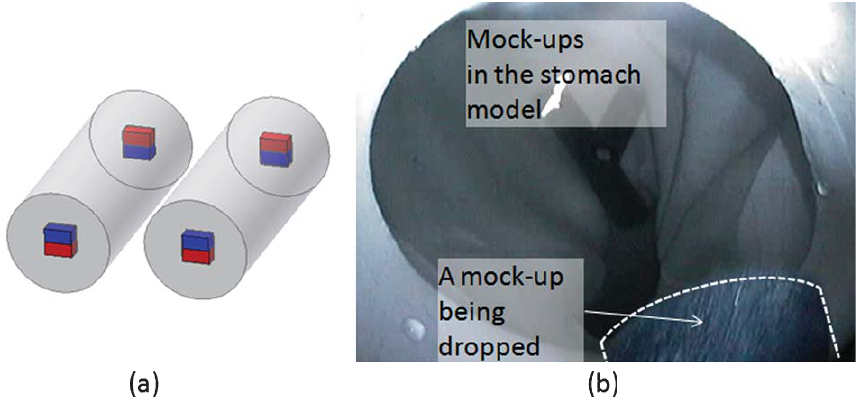
Fig. 9. (a) Design of the mock-up with two magnets. (b) Endoscopic view during the